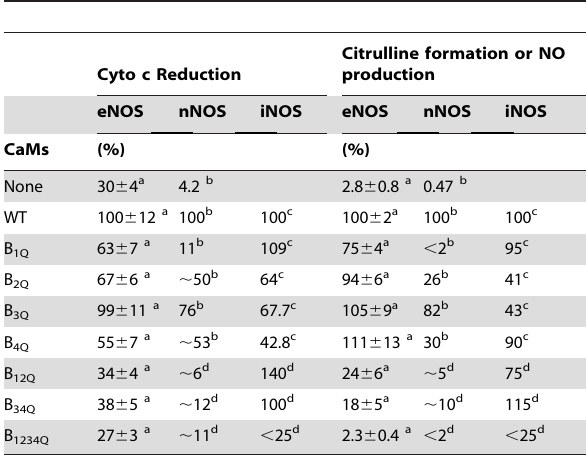
type CaM were , 14 min 2 1 min 2 1 for citrulline formation, and , 286 min 2 1 for cytochrome c reduction. b Data from Ref. 21. c Data from Ref.